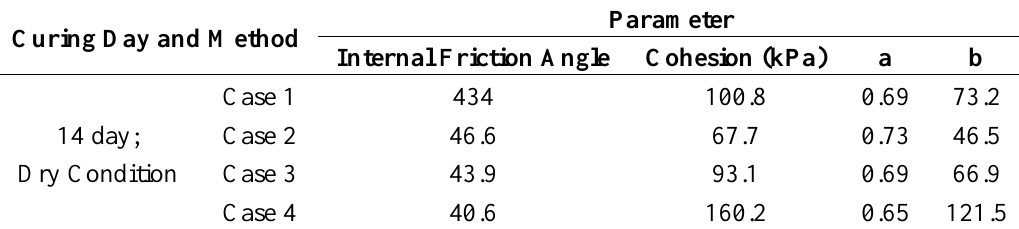
Table 5. Test Results of Triaxial